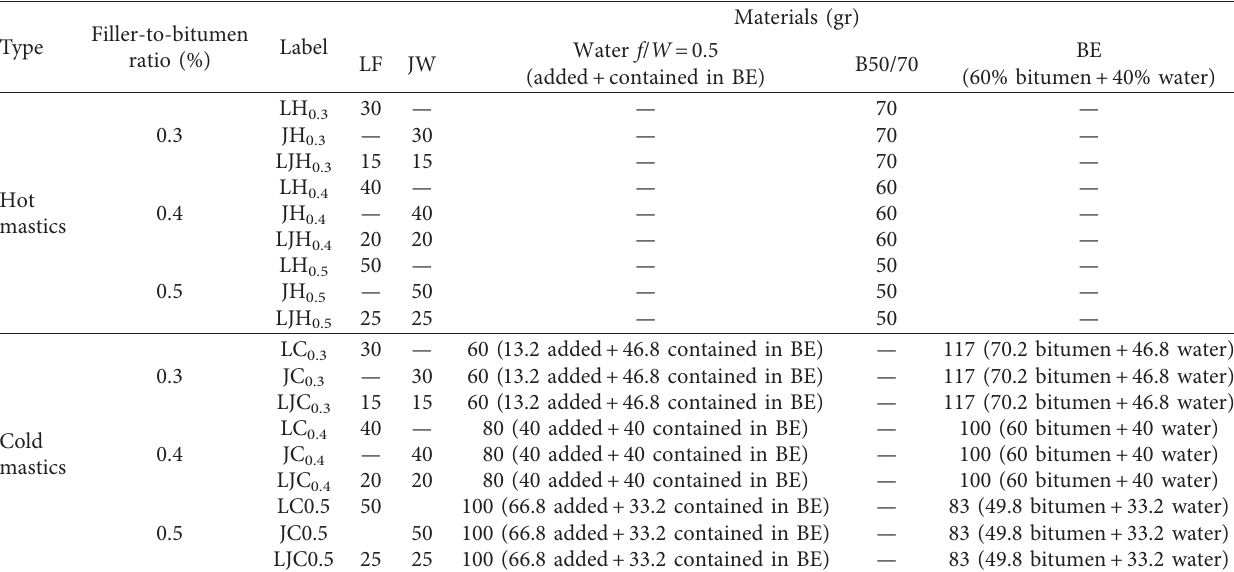
Figure 3: Mastic preparation using jet grouting waste. (a) Filler preparation: (A) cold mastic and (B) hot mastic. (b) Adding filler to the binder: (A) cold mastic and (B) hot mastic. (c) Final mastic: (A) cold mastic and (B) hot mastic. Table 3: Amount of mastic mixing materials per 100gr of the study